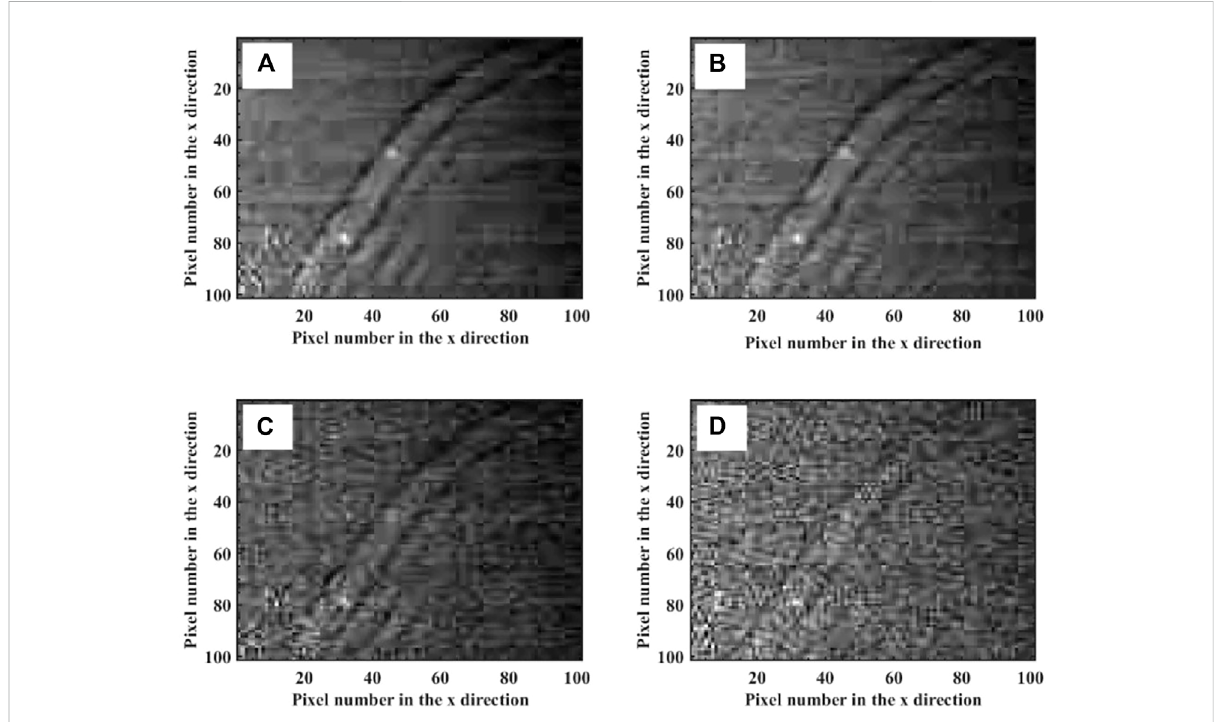
FIGURE 4 DNB image of internal wave phenomenon in the South China Sea region on 7 April 2020(8.0 – 9.2N, 118.2 – 119.4E), (A) is the original image without anynoise added, (B) is theimage with 0.2 randomnoise added on thebasis of (A) , (C) isthe image with 0.4 random noise added on the basis of (A) , (D) is the random noise image with 0.6 added on the basis of (A)